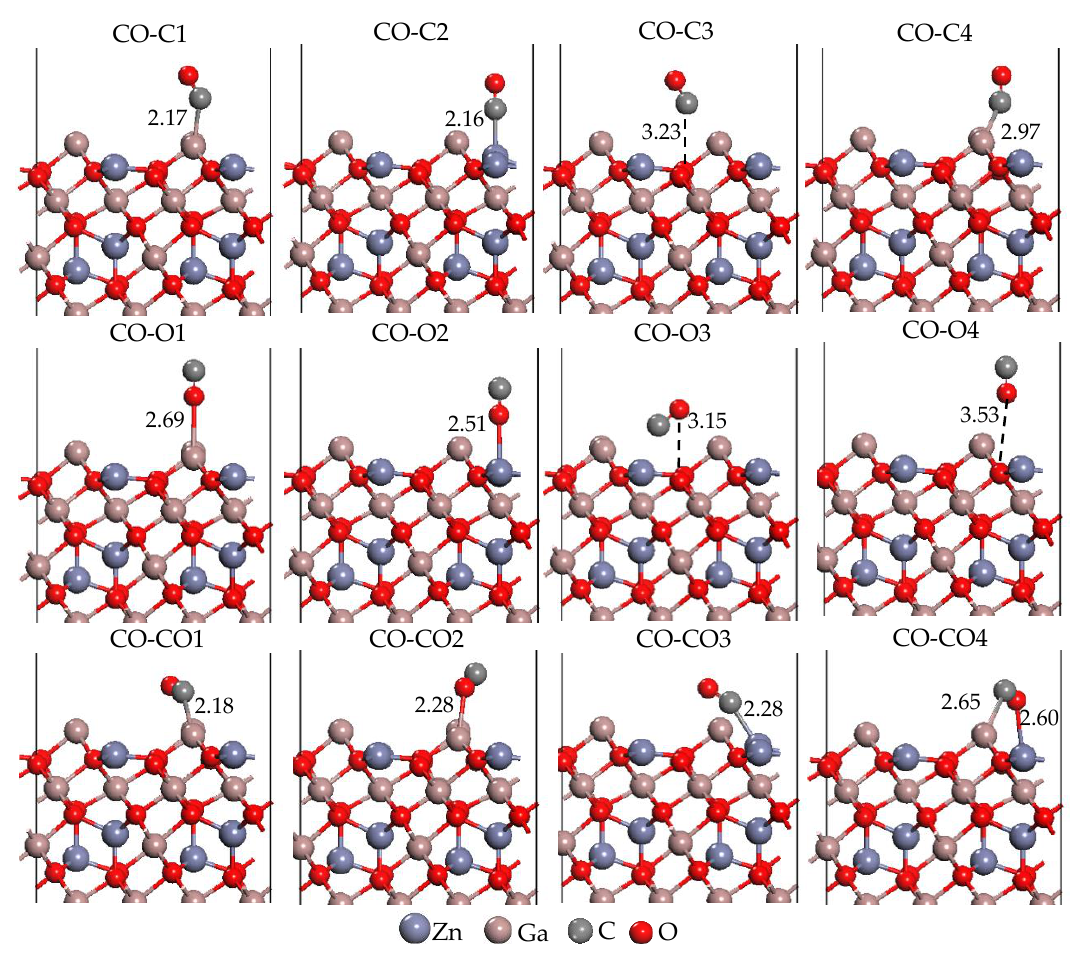
Figure 2. Ball and stick structural representations of the optimized CO-C i , CO-O i and CO-CO i considered in this study. Atoms are represented by spheres: Zn (gray, large), Ga (brown, large), C (gray, medium-sized), and O (red, small). Bond lengths are given in Å .